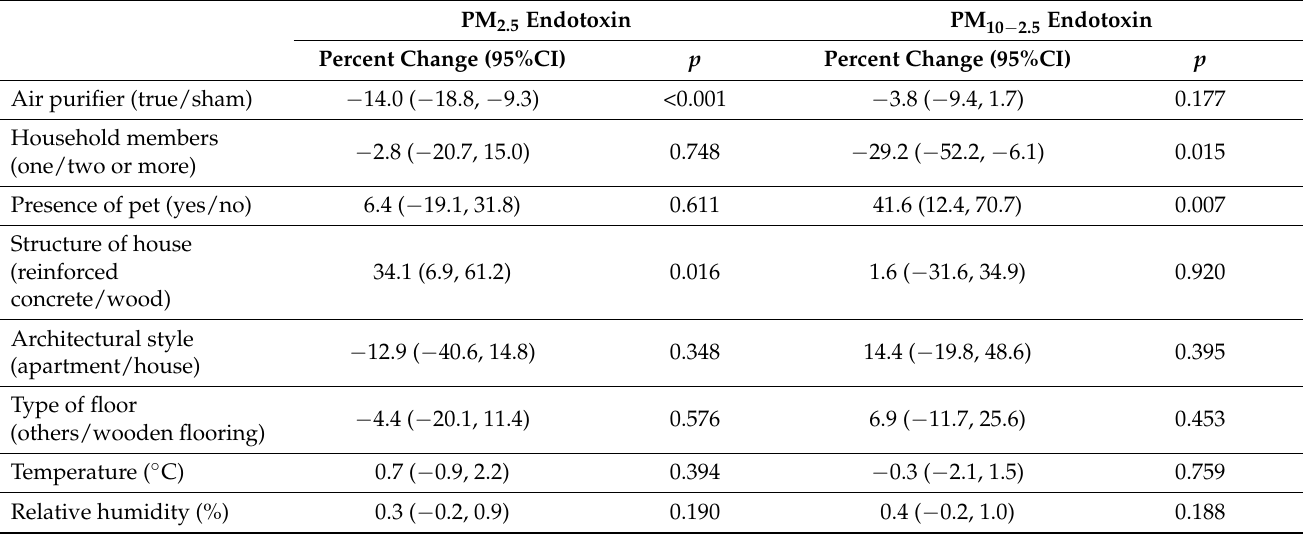
Table 3. The percent changes in endotoxin concentrations related to household characteristics and meteorological factors.